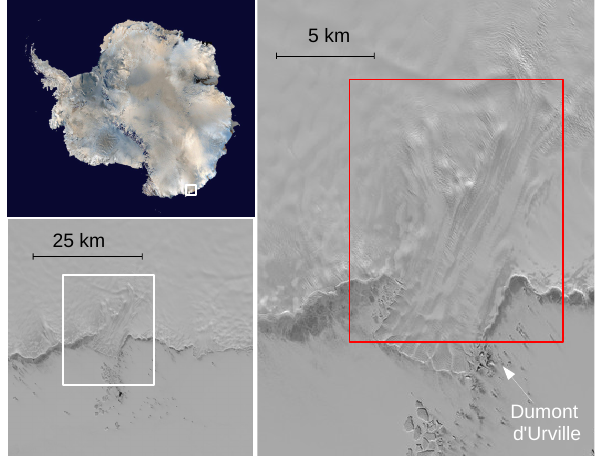
Figure 1. Location of the Astrolabe Glacier in the Terre Adélie sector of East Antarctica from an Advanced Very High Resolution Radiometer (AVHR) global picture (upper left). The regional view (lower left) as well as the focus on the coastal part of the glacier (right) come from a SPOT High Resolution Geometric (HRG1) im- age taken on the 28 November 2003 (©CNES/Distribution Spot Im- age). The red square shows the location of Fig. 4.